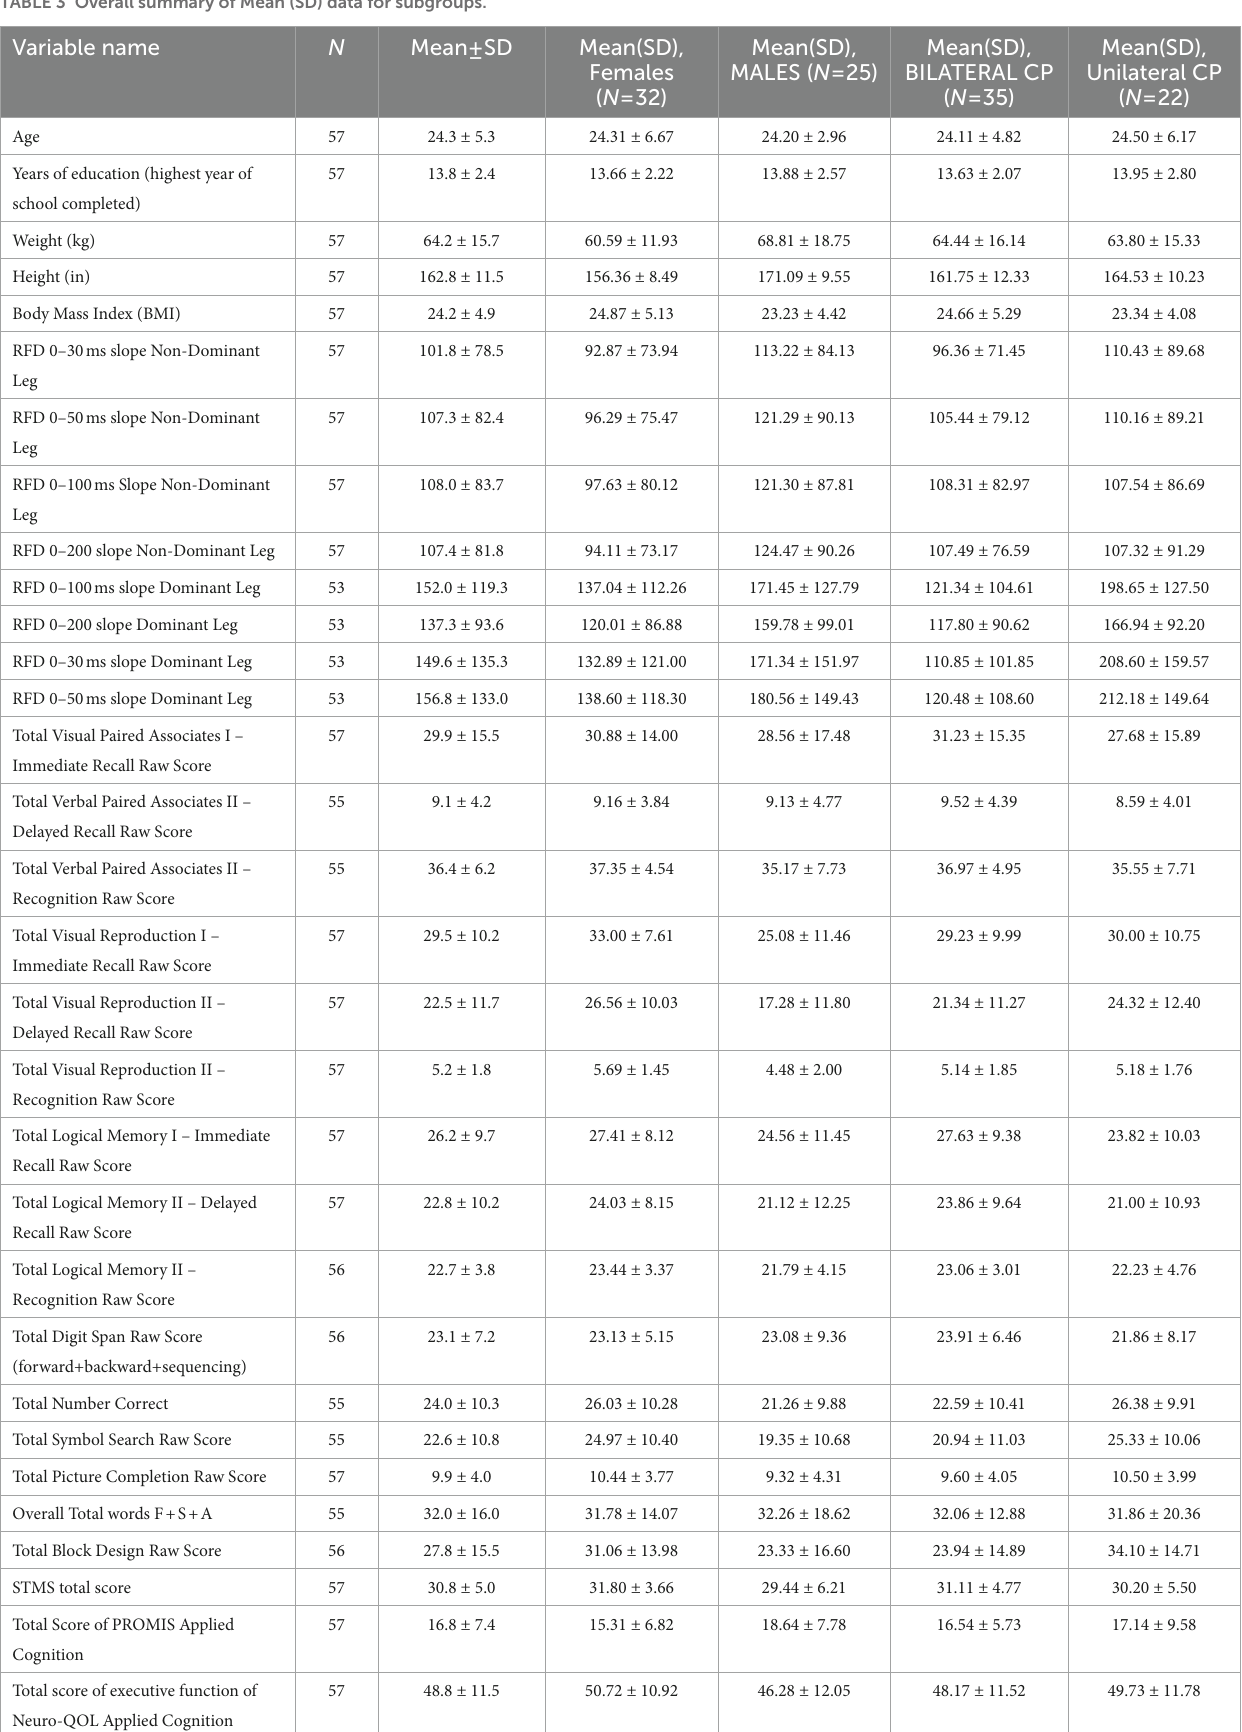
TABLE 3 Overall summary of Mean (SD) data for